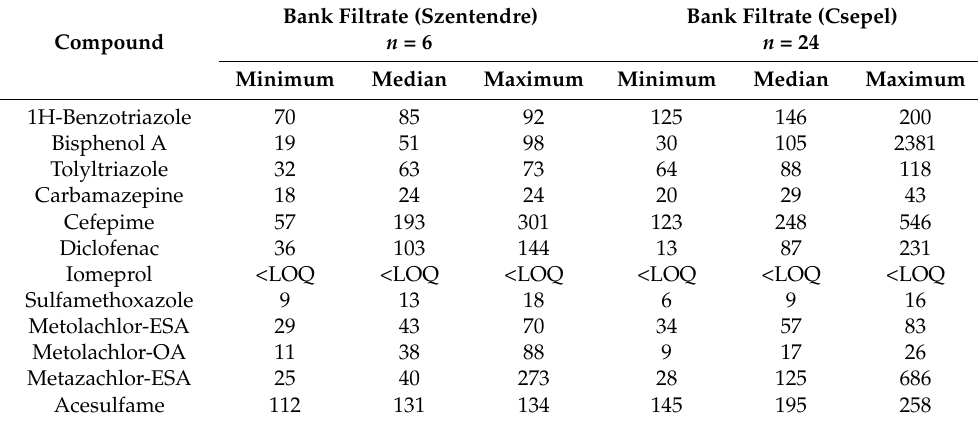
Table 3. Minimum, median, and maximum concentrations in ng/L of most prominent compounds in bank filtrate at sampling points on Szentendre Island and Csepel Island.